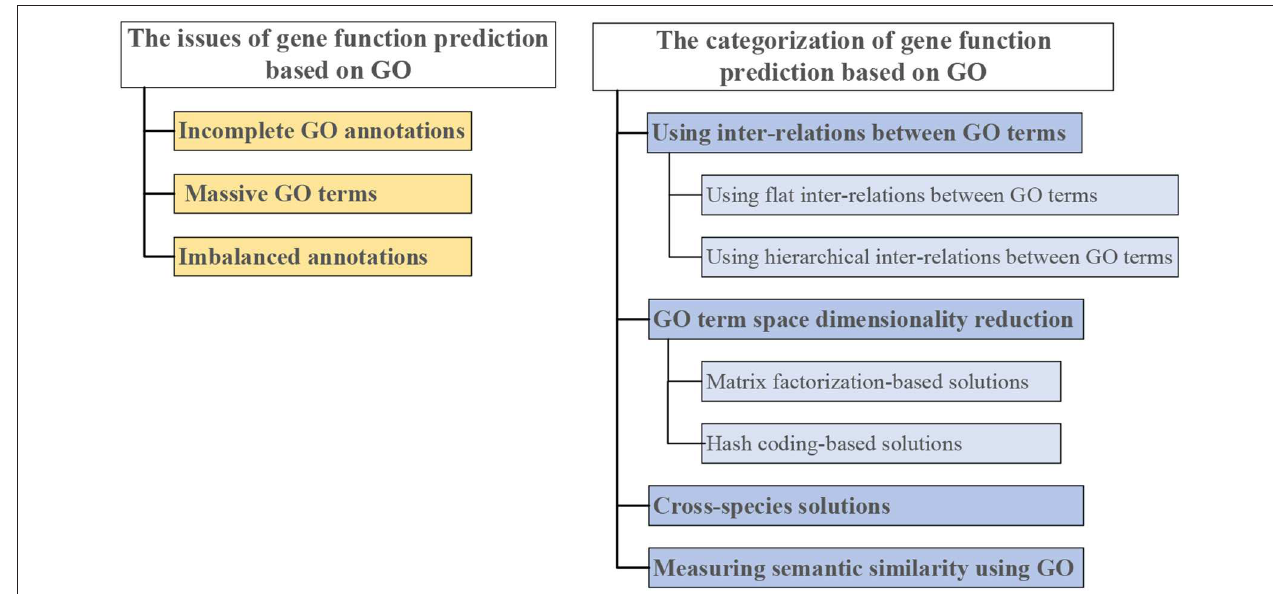
FIGURE 3 | Three issues in gene function prediction (left) , and categorization of existing computational solutions based on GO (right) .